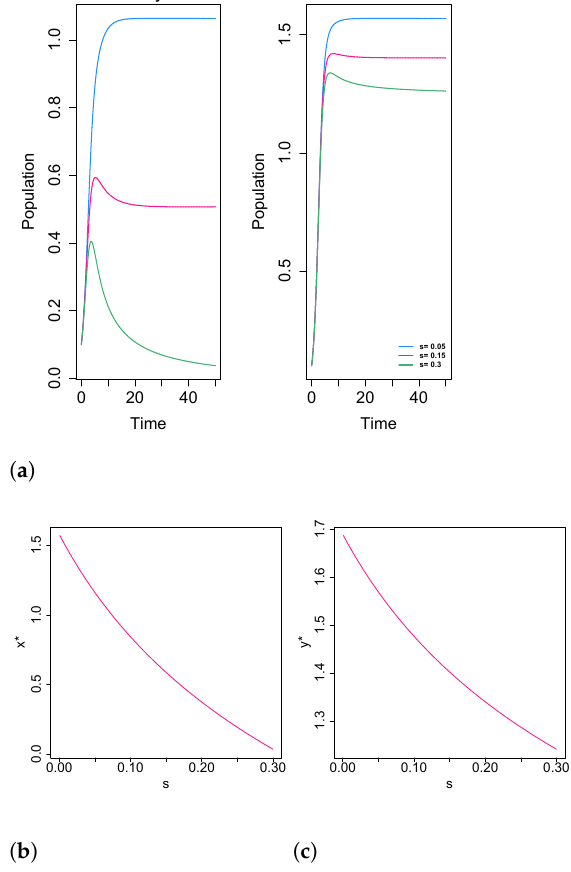
Figure 5. Variation of the positive equilibrium and the solutions in function of parameter s . The considered values of the parameters are r = 1.6, d = 0.8, a = 0.2, p = 0.3, c = 0.8, n = 1 and d 1 = 0.8. ( a ) Solutions for x ( 0 ) = 0.1 and y ( 0 ) = 0.1. ( b ) Variation of x ∗ . ( c ) Variation of y ∗ .